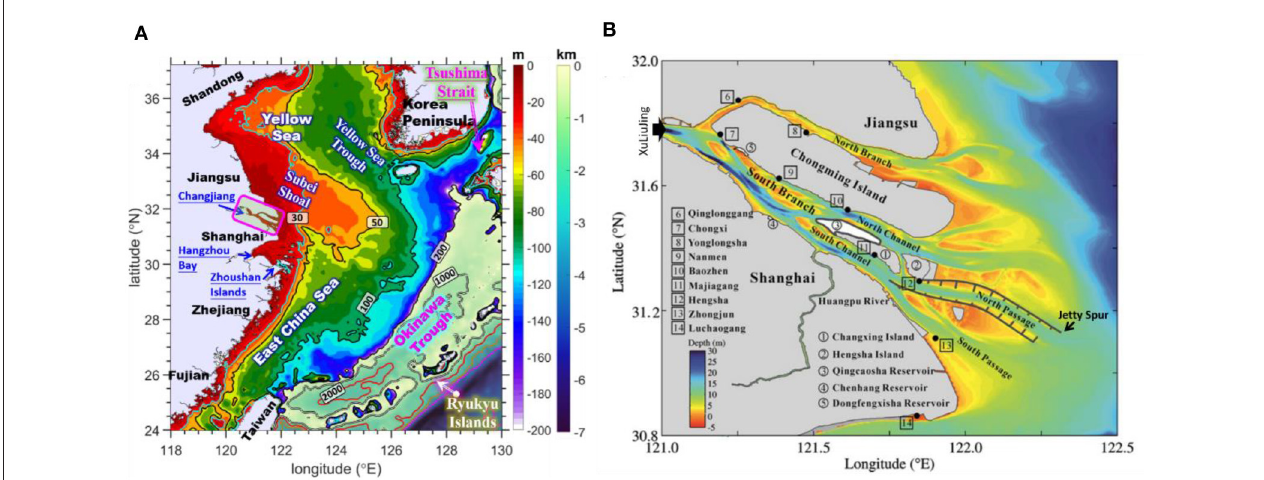
FIGURE 1 | (A) Water depth (m) of ECS and YS. The waters deeper and shallower than 200m in this figure are illustrated by different colormaps. The 30, 50, 100, and 200m isobaths over the shelf, and 1,000, 2,000, 3,000, 4,000m isobaths in the deeper oceans are also shown. The bathymetry is composed from the digitalized navigation map in the coastal areas and the ETOPO1 global relief model. (B) Water depth (m) in Changjiang Estuary with name of the branches, channels, passages, and islands ( Zhu et al., 2019). The underwater jetty spur bordering the North Passage is shown in (B)